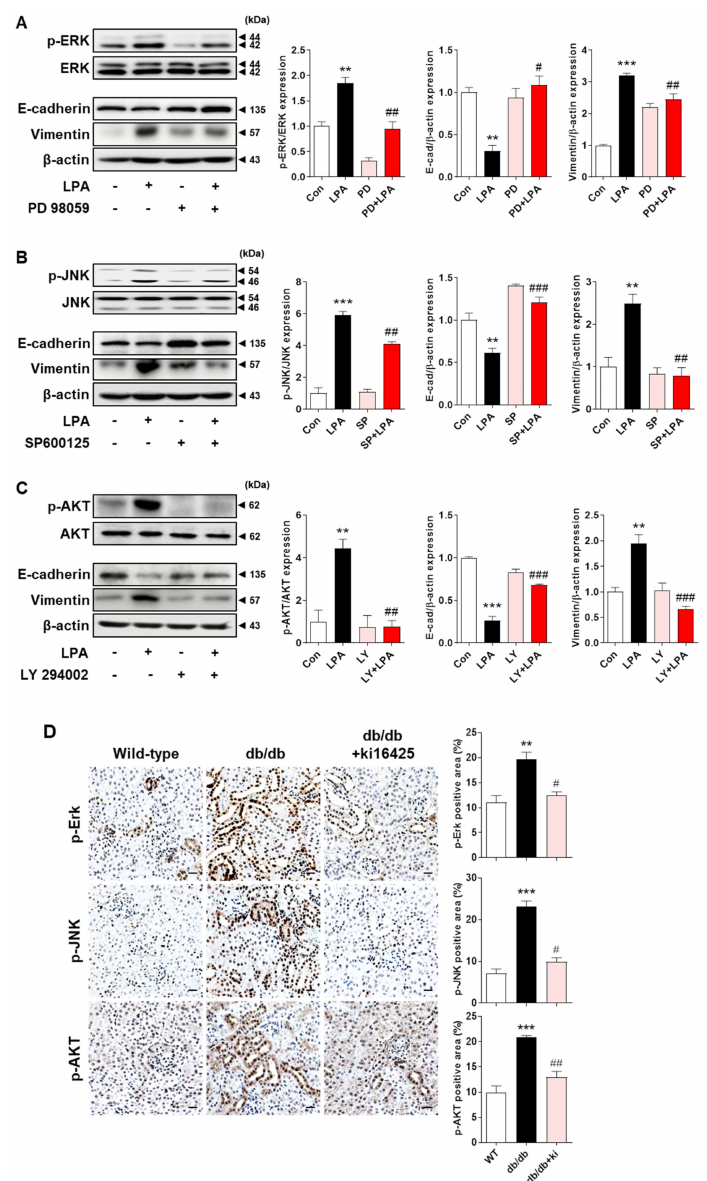
Figure 7. LPA induced EMT marker expression via the MAPK and AKT signaling pathways. ( A – C ) HK-2 cells were pretreated with the vehicle (DMSO), 10 µ M PD 98059 (PD; an ERK inhibitor) ( A ), 10 µ M SP600125 (SP; a JNK inhibitor) ( B ), or 2.5 µ M LY 294002 (LY; a PI3K/AKT inhibitor) ( C ) for 1h and subsequently treated with 20 µ M LPA for 30 min (for p-ERK, p-JNK, and p-AKT) or 48h (for E-cadherin and vimentin). Protein levels of E-cadherin, vimentin, p-ERK, p-JNK, and p-AKT were analyzed via Western blotting, quantified using ImageJ software, and normalized to those of β -actin, total ERK, total JNK, and total AKT, respectively. Representative images (left) and graph analysis bar graphs (right) are shown ( n = 3 independent experiments). Data are presented as the mean ± SEM. ** p < 0.01, *** p < 0.005 vs. Con; # p < 0.05, ## p < 0.01, ### p < 0.005 vs. LPA. ( D ) The animal experiments are described in the Materials and Methods section. Immunohistochemical detection of p-ERK, p-JNK, and p-AKT was performed in the kidney tissues using specific antibodies and DAB. The nuclei were counterstained with hematoxylin. The positive expression area of each target gene was quantified using ImageJ software. Representative images (left) and quantitative analysis bar graph (right) are shown. Original magnification, 200 × ; scale bars, 20 µ m; n = 3 mice per group. Data are presented as the mean ± SEM. ** p < 0.01, *** p < 0.005 vs. wild-type (WT); # p < 0.05, ## p < 0.01 vs.